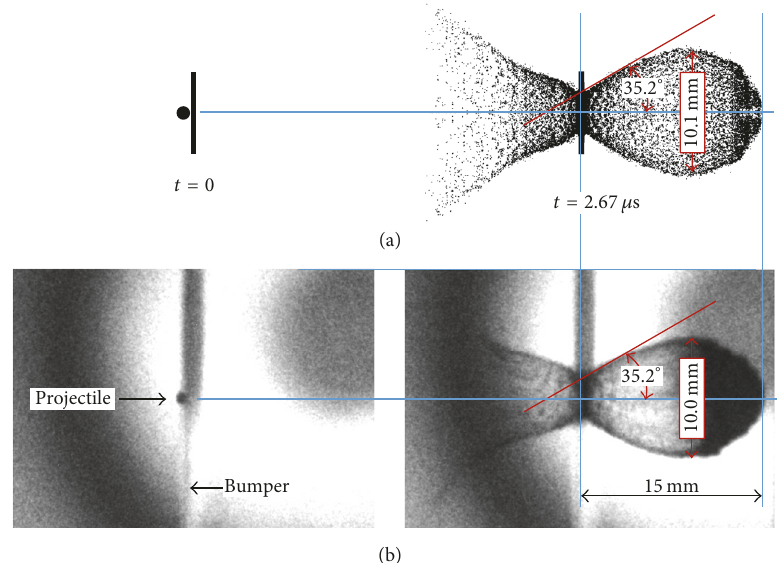
Figure 6: Results of numerical modeling (a) and experimental observations (b).